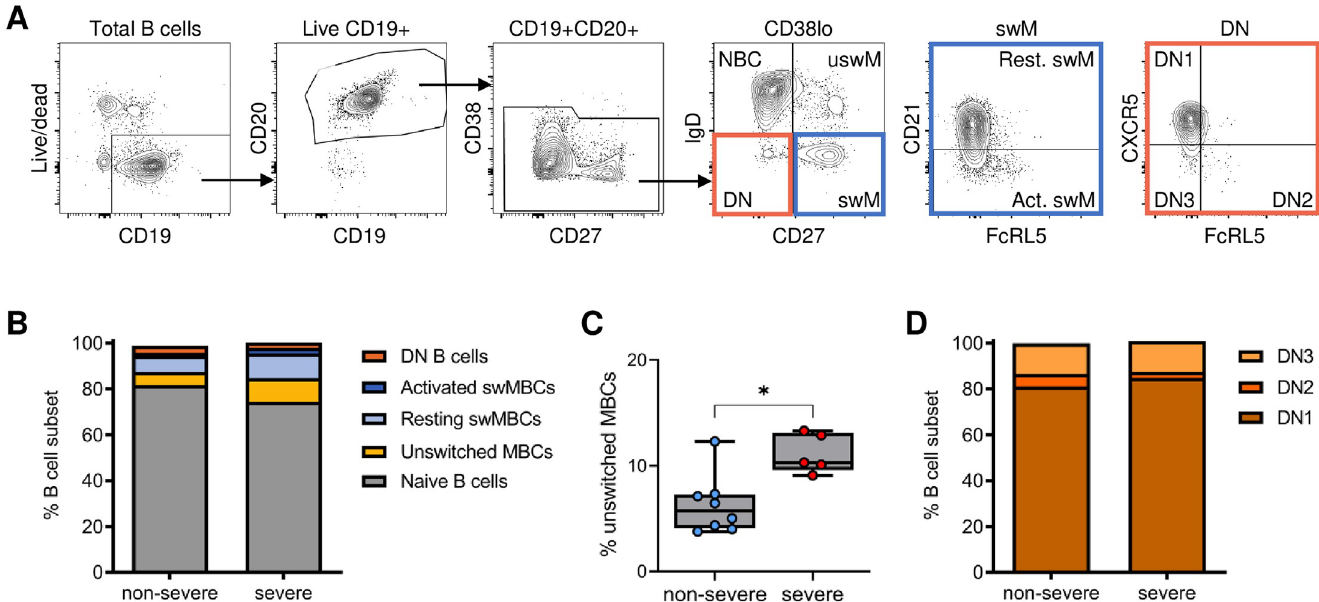
Fig 2. Distribution of major B cell subsets in recovered COVID-19 patients. A) Gating strategy to obtain non-antibody-secreting B cells (CD38lo) that are further divided into na ï ve, unswitched memory (uswM), switched memory (swM), and double negative (DN). SwM B cells were divided into activated and resting populations based on the expression of CD21. DN cells were divided into DN1–3 based on the expression of FcRL5 and CXCR5. B) Median percentage of each B cell subset in samples from individuals who recovered from non-severe COVID-19 and severe COVID-19. C) Percentage of unswitched memory B cells, which was increased in individuals who recovered from severe disease as compared to those who had non-severe COVID-19. D) Median proportions of the three different DN populations 1 month after non-severe or severe disease. In panel B–D, results are shown for individuals who recovered from non-severe COVID-19 (n = 8) and severe COVID-19 (n = 5). See S1 Fig for graphs with individual data points for the data shown in panels B and D. � P < 0.05.